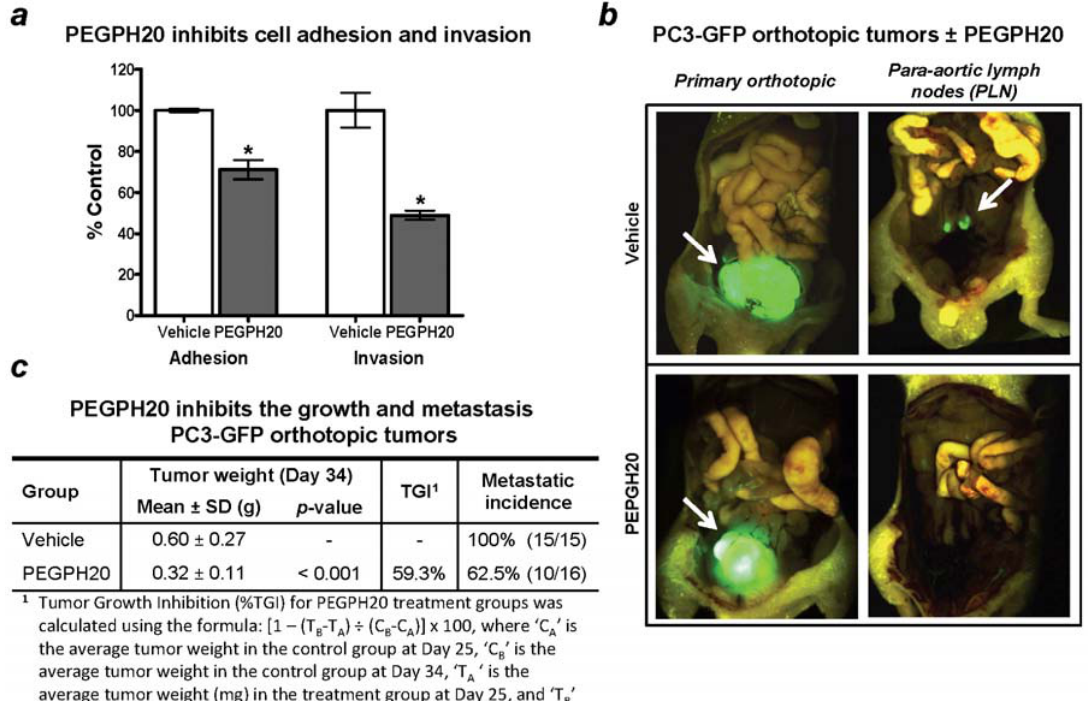
Figure 9. PEGPH20 effects on metastasis. PEGPH20-mediated HA removal inhibits cell adhesion, cell invasion and reduces metastatic incidence. ( a ) PEGPH20-mediated in vitro pericellular HA removal reduced cell adhesion by 29% ( p < 0.001) compared to vehicle alone and reduced the number of PC3 cells invading downward through invasion chambers toward the chemoattractant EGF by >50%, relative to control ( p < 0.001). Cell adhesion was evaluated as per Cos et al. [169], with modifications. Briefly, PC3 cells in culture were harvested, counted, and divided into two groups: growth medium plus 0.1% bovine serum albumin (BSA), and growth medium plus 0.1% BSA and 1,000 U/mL PEGPH20. Both suspensions were then incubated at 37 °C for 1 h. Cells were subsequently seeded (1.5 × 10 5 cells/well, n = 5 wells/treatment) onto Matrigel-coated plates and allowed to adhere for 1 h at 37 °C. At 1 h, non-adherent cells were gently removed by washing, and attached cells were then harvested, counted, and expressed as percent relative to control cell adhesion ± SEM. For cell invasion, PC3 cells were incubated with vehicle alone or PEGPH20 (1,000 U/mL) and seeded onto the upper chamber of invasion chambers with either vehicle buffer, or in the case of the PEGPH20-treated cells, additional PEGPH20 to prevent the re-synthesis of HA-rich pericellular matrices. The number of cells invading downward through Matrigel was expressed as percent relative to control cell invasion ± SEM; ( b ) Representative images of PC3-GFP primary orthotopic tumors, and metastatic PLNs, visualized after removal of the primary tumors; ( c ) PEGPH20 treatment (4.5 mg/kg; q3d × 3), starting at Day 25, inhibited tumor growth of the primary tumor by >59% within 9 days (by Day 34). Further, the incidence of metastatic PLN tumors was reduced in PEGPH20-treated animals by ~38%, when compared to vehicle-treated animals (100% incidence in vehicle-treated versus 62.5% incidence in PEGPH20-treated animals, respectively, p <